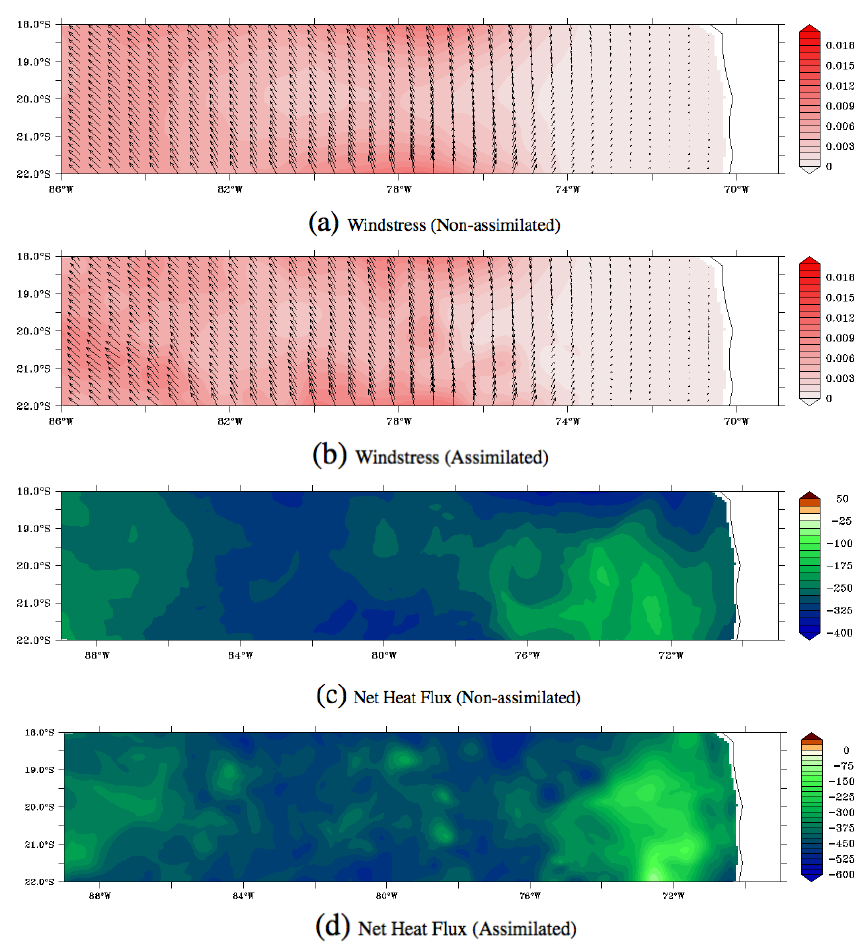
Fig. 8. Windstress (Nm − 2 ) forcing for the ROMS model for the period from Nov 16–31 November 2008 before (a) and after (b) adjustment from assimilation of observations. Net Heat flux (Wm − 2 ) forcing for the ROMS model for the period from 16–31 November 2008 before (c) and after (d) adjustment from assimilation of